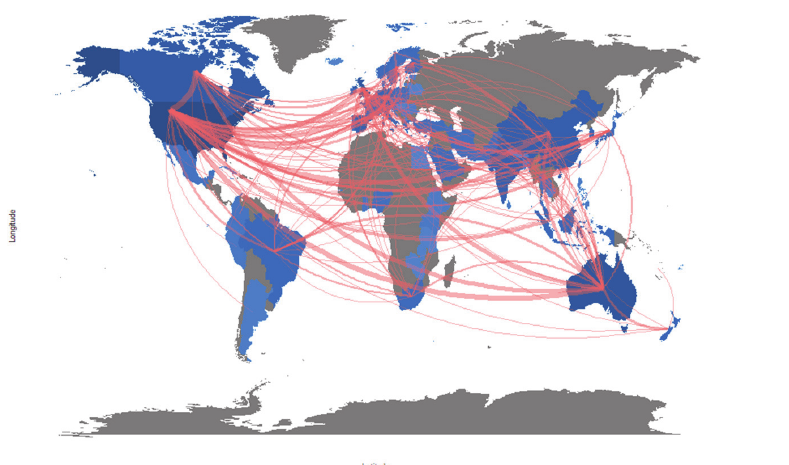
Fig. 5. Country Collaboration